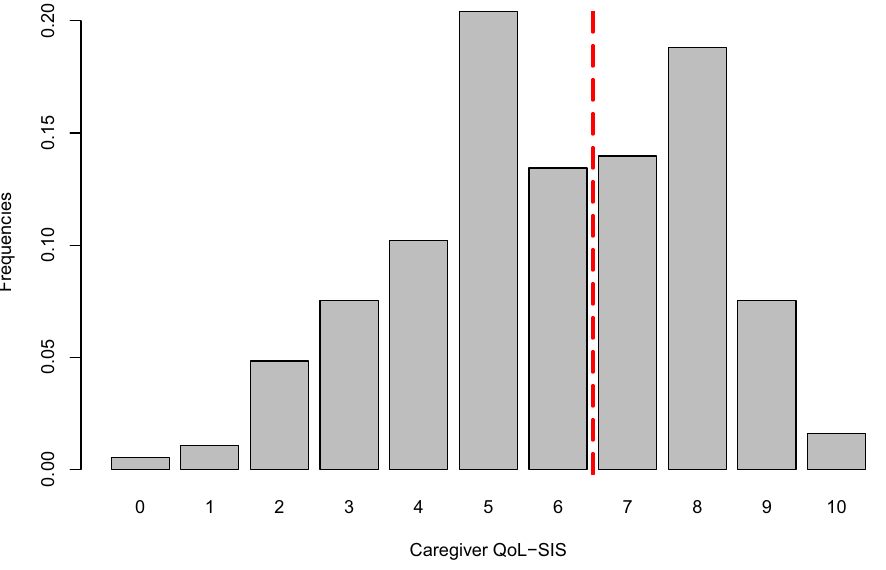
Figure 1. Barplot of MQoL-SIS scores. The vertical line between 6 and 7 demonstrates the way the data was split. The value 6 was the median of the distribution and was included in the low QoL